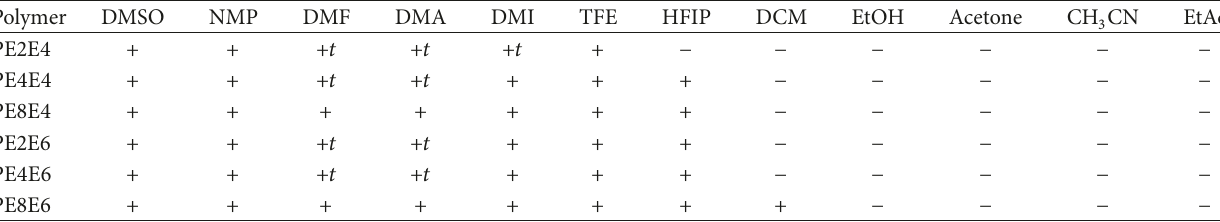
Table 12: Solubility of the click PEs in organic solvents (10mg of polymer in 1mL solvent). Polymer